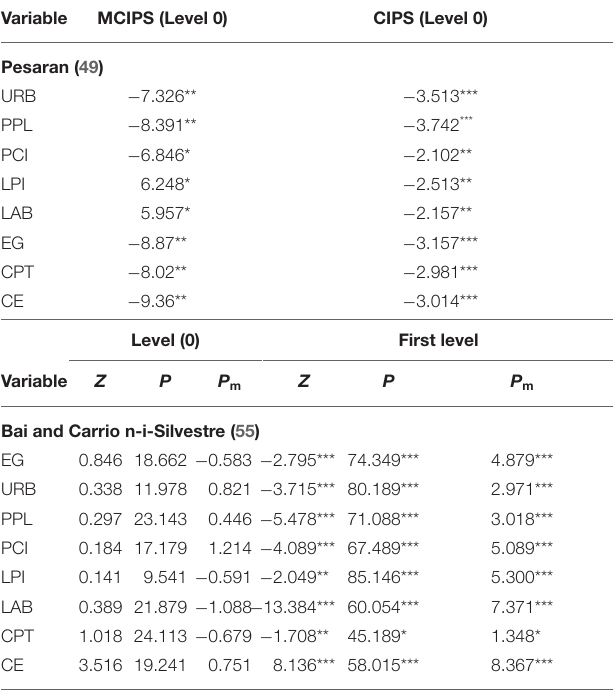
TABLE 3 | Result of unit root test.